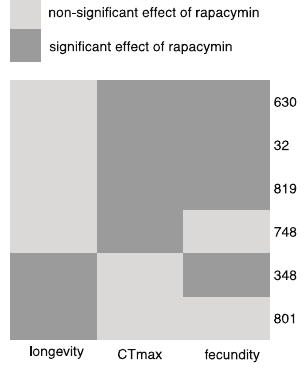
Figure 4. Trait-correlations between basal trait level (control treatment) and the phenotypic re- sponse to treatment (expressed as y control -y rapamycin , where y represent one of the three phenotypes) for CT max ( A ), fecundity ( B ) and longevity ( C ). Results are based on the within treatment line means. Spearman’s rank correlation coefficients ( 𝜌 ) with corresponding significance levels are shown for each trait. Numbers above each point are the DGRP line IDs.